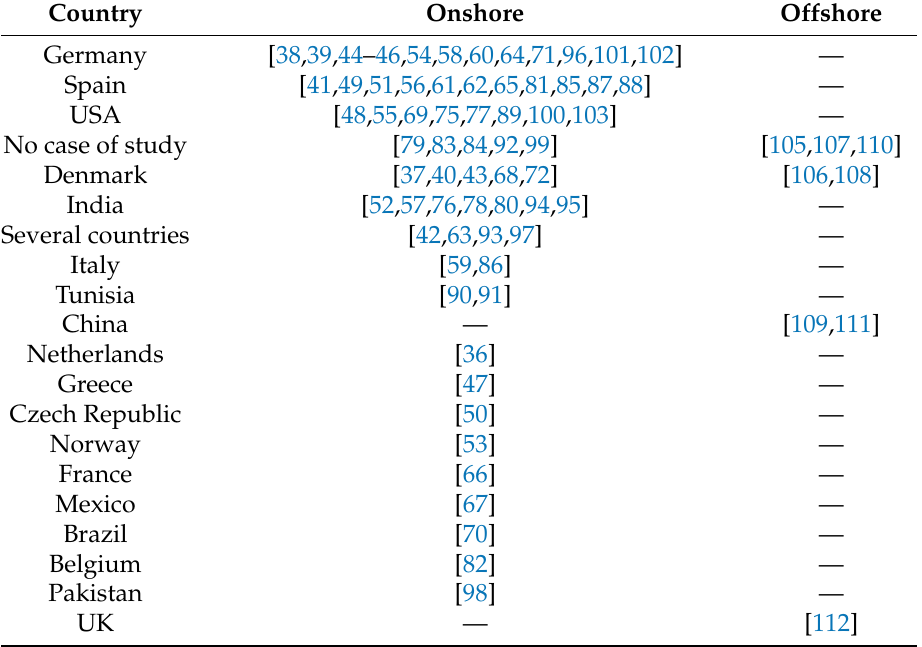
Table 5. Revised papers by country and technology. Period (2000–2021).